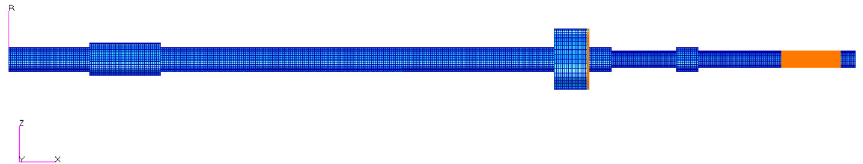
Figure 11. Modal analysis axial constraints.